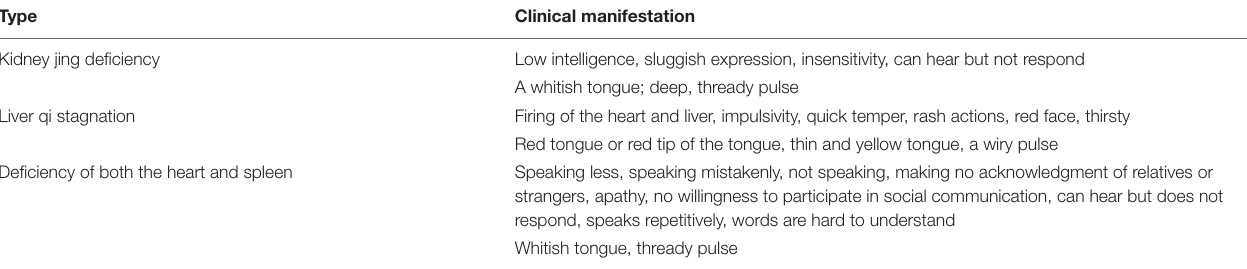
TABLE 1 | TCM syndrome differentiation of